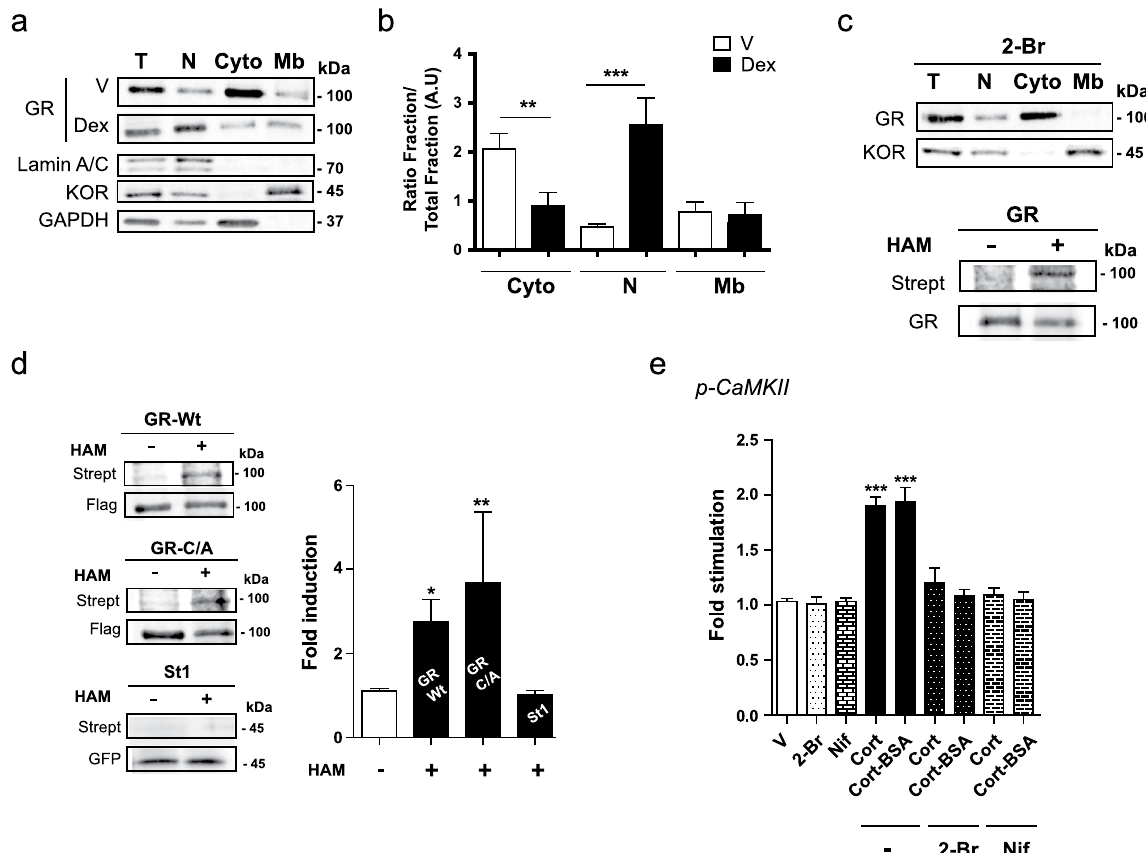
Figure 3. A palmitoylated membrane GR is involved in GC-induced rapid CaMKII phosphorylation in L β T2 cells. ( a ) L β T2 cells were treated or not (V) with Dex before subcellular fractionation to detect GR and specific markers by WB; lamin A/C, κ -opioid receptor (KOR) and GAPDH for nuclear/debris (N), membranous (Mb) and cytosolic (Cyto) fractions, respectively. T: total extract. ( b ) Quantification of GR in each fraction of L β T2 cells treated or not (V) with Dex, in comparison with T. Results are expressed as means ± SEM fold stimulation when compared to T, one-way ANOVA with Newman-Keuls Multiple Comparison Test, n = 4 experiments, ** p < 0.01, and *** p < 0.001. ( c ) Upper panel, L β T2 cells were pre-incubated with 2-Br prior to cell fractionation. Equal amounts of proteins were analyzed by WB. n = 3 experiments. 2-Br: 2-bromopalmitate. Lower panel, L β T2 cell lysates were subjected to ABE assay after GR immunoprecipitation, followed by SDS-PAGE with the minus ( − ) and plus ( + ) HAM samples. Palmitoylation was detected by WB comparing streptavidin (Strept) signal to GR one. n = 3 experiments. ( d ) HEK293 cells were transfected with GR Wt , GR C/A or stathmin 1-GFP (St1). Cell lysates were subjected to the ABE protocol followed by SDS-PAGE as described in ( c ). Strept signals detecting palmitoylation were normalized to the level of immunoprecipitated Flag-GR or GFP-St1 detected on the same membrane. Graph shows the average normalized densitometry data (Strept signal divided by anti-Flag or anti-GFP signals) displayed as fold induction of ( + ) HAM/( − ) HAM control samples. One-way ANOVA with Dunnett’s posttest ( n = 4 experiments, * p < 0.05, ** p < 0.01). ( e ) L β T2 cells were pretreated with 2-Br or Nifedipine (Nif) respectively, and then treated with either Cort or Cort-BSA for 5 min. Cell lysates were subjected to WB with anti-CaMKII, anti-p-CaMKII, and anti- α -tubulin antibodies. Results are expressed as means ± SEM fold stimulation when compared to vehicle (V). One-way ANOVA with Dunnett’s post-test, n = 3 experiments, *** p < 0.001 when compared to V. Cropped blots are shown. Full length WBs are presented in Supplementary Fig.